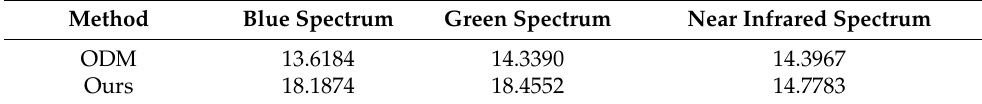
Table 5. PSNR values of ODM and our methods on BGNIR multispectral aerial image mosaic.